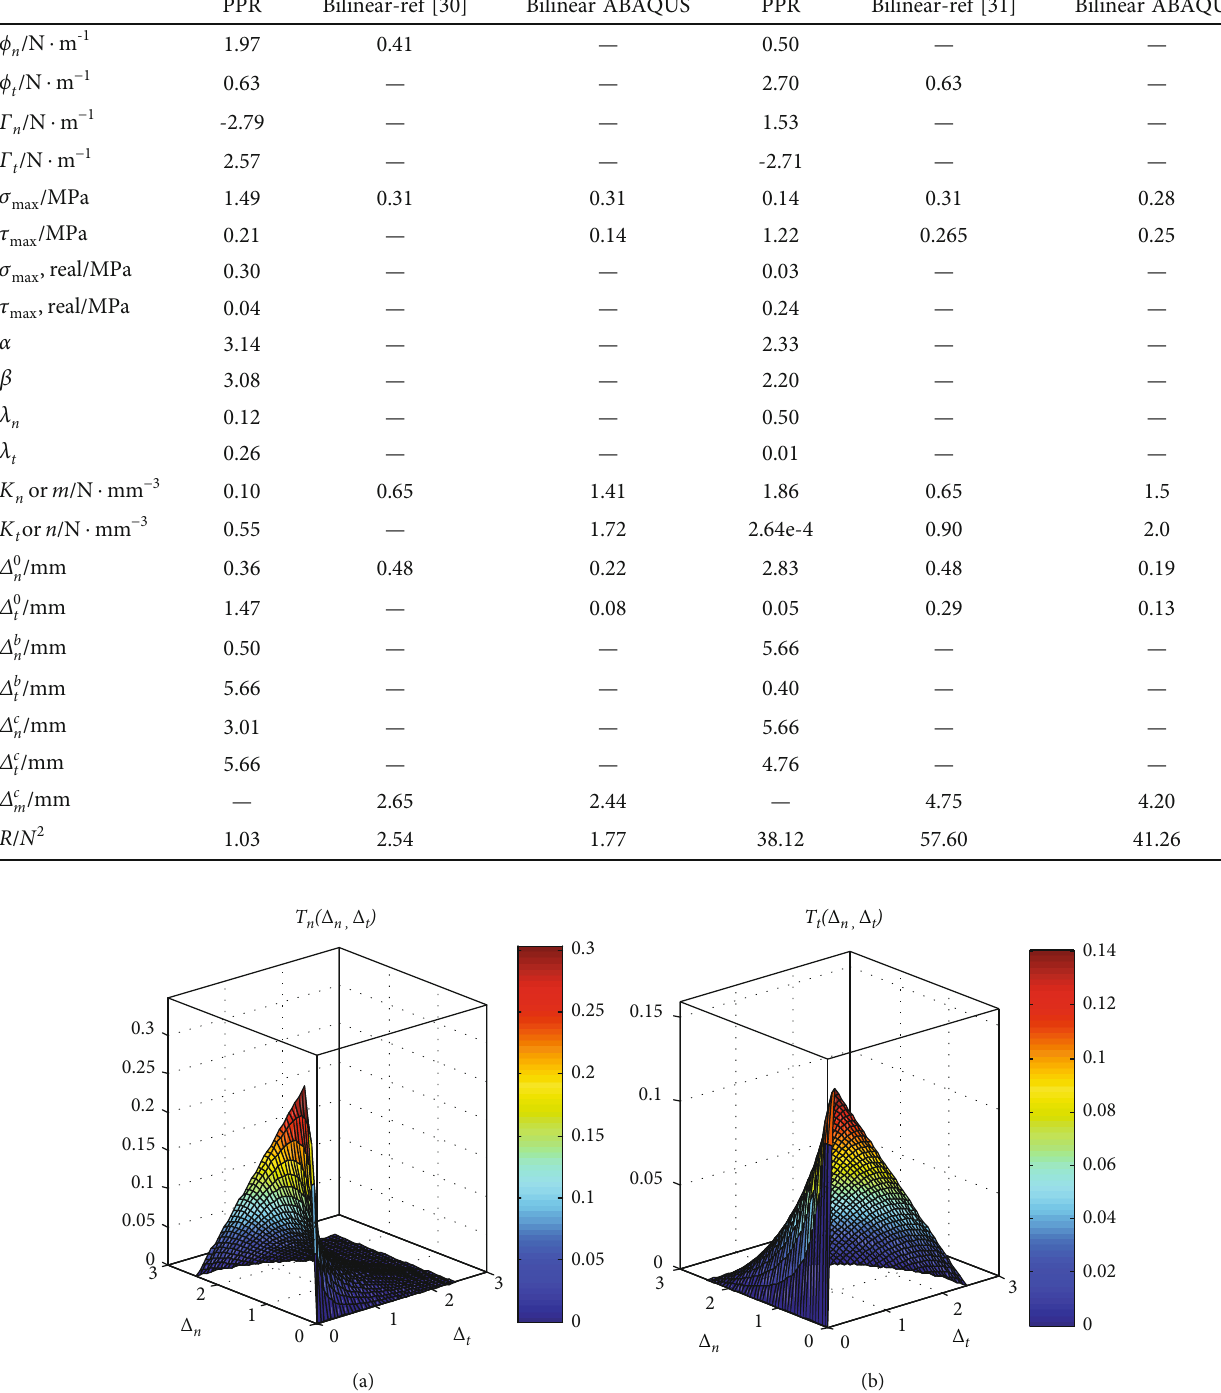
Figure 13: (a) Nominal and (b) tangential cohesive traction with respect to displacement separation ð Δ in DCSB test; units: Δ n , Δ t , mm; T n , T t , Displacement versus time relation is plotted in Figure 8. The stress results (normal stress) and its theoretical value of user element based on element ’ s real separation versus displace-